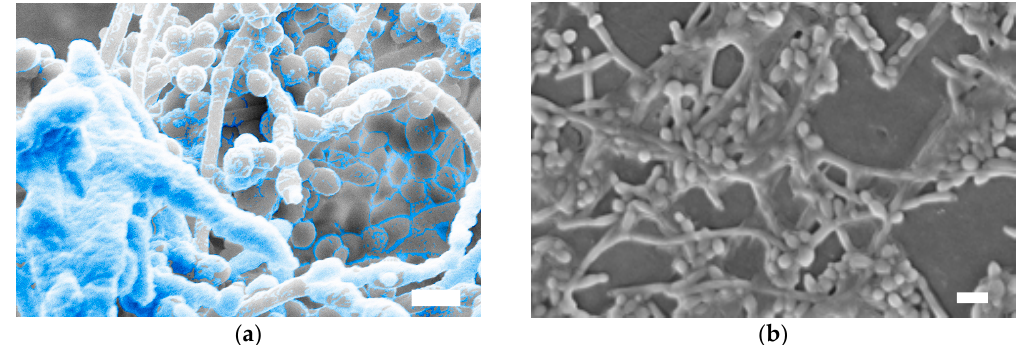
Figure 1. Scanning Electron Microscopy (SEM) images showing the presence of extracellular matrix in Candida albicans biofilms. ( a ) Biofilm samples were fixed and dehydrated for processing for SEM; ( b ) biofilm samples were air-dried and not fixed to maximize the preservation of exopolymeric